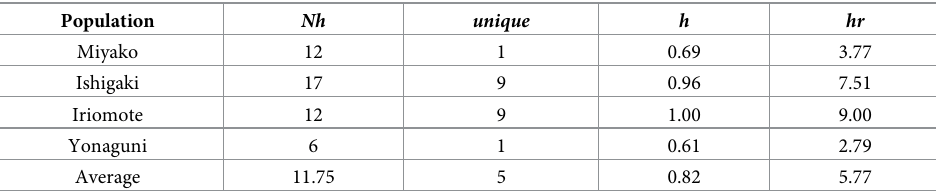
Table 1. mtDNA haplotype diversity.